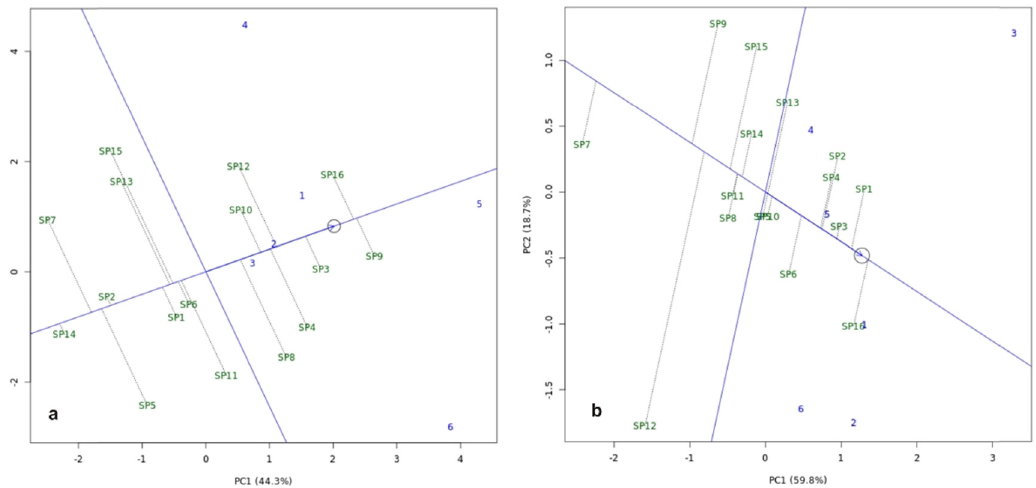
Figure 6: Biplot of average and stability of new honey sweet potato genotypes. ( a ) Storage root yield character and ( b ) sweetness